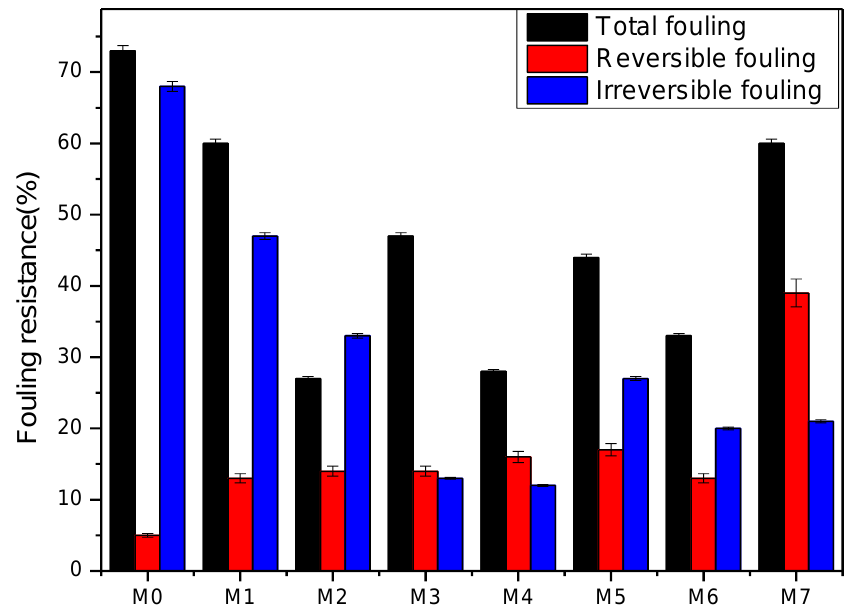
Figure 17. Fouling resistance ratio of M0–M7 membranes.